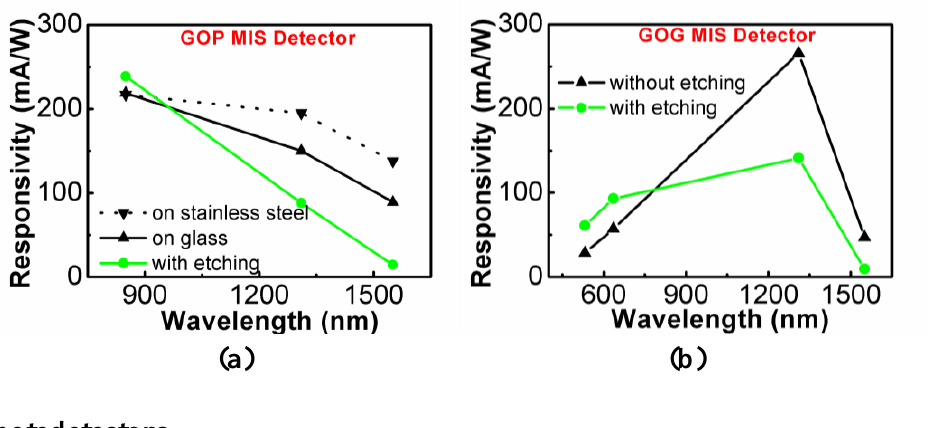
Figure 22. The responsivities of: (a) GOG MIS photodetectors; (b) GOP MIS photodetectors. Reprinted from [62,63] with permission of the American Institute of Physics (Copyright 2007 &